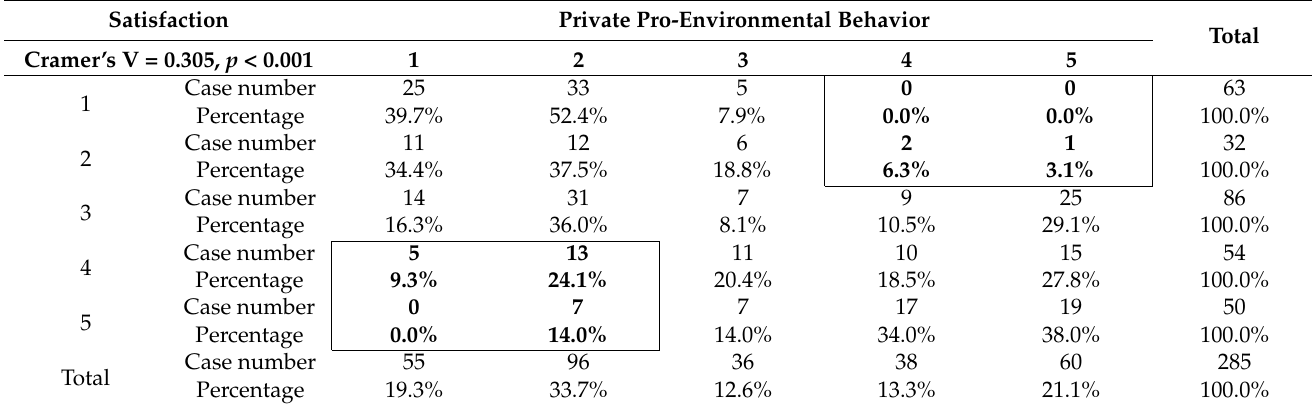
Table 7. Cross-contingency table of satisfaction and private pro-environmental behavior.